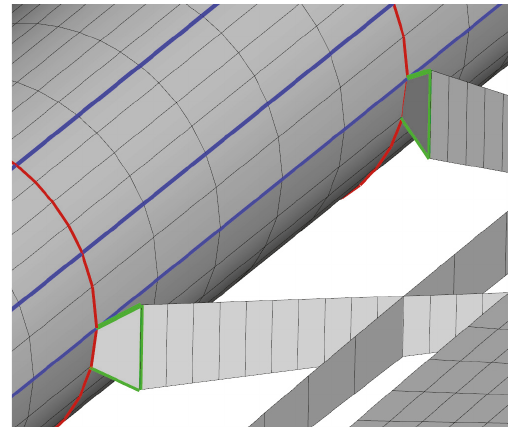
Figure 9: The structural connection mesh between the fuselage and the